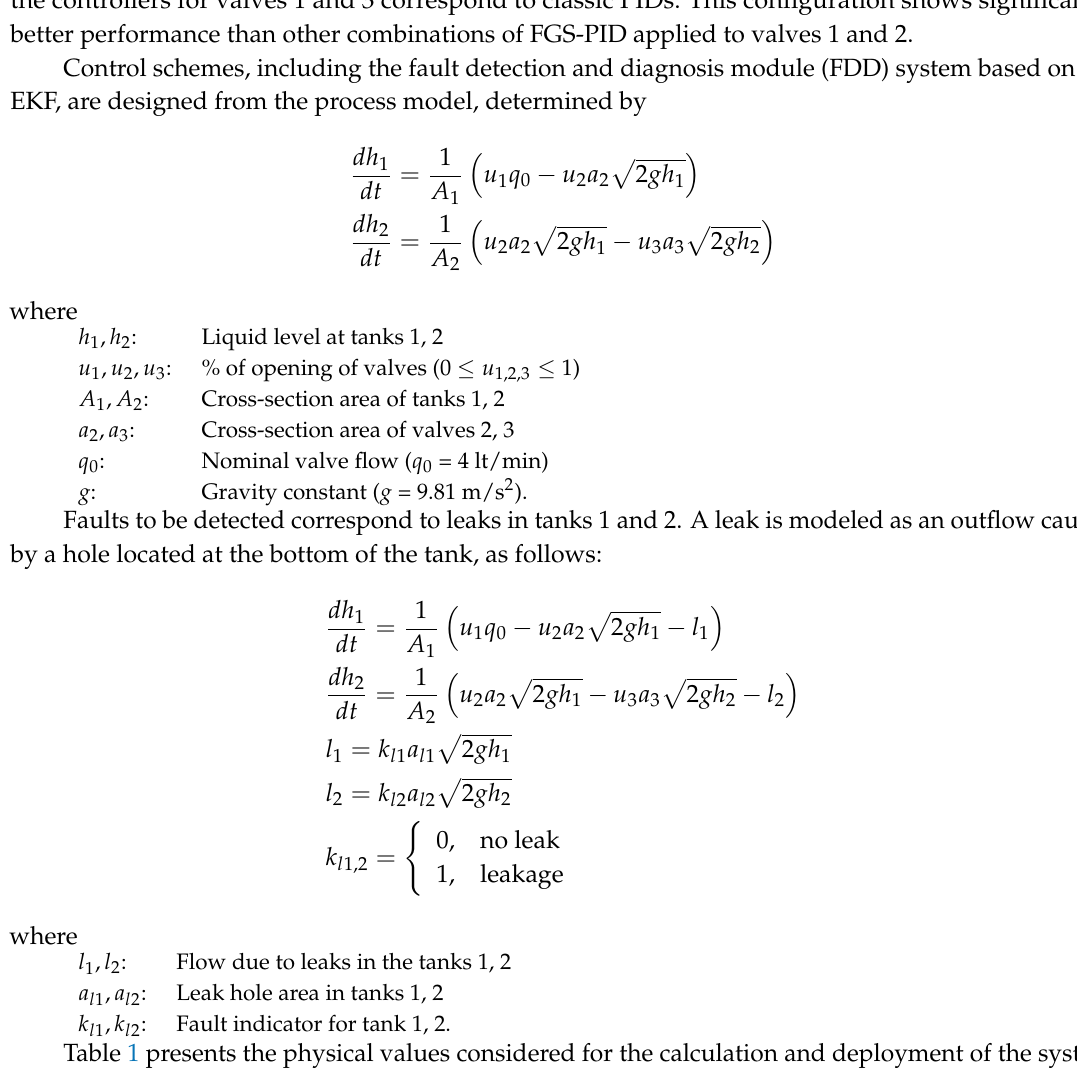
Table 1. Physical constants of the